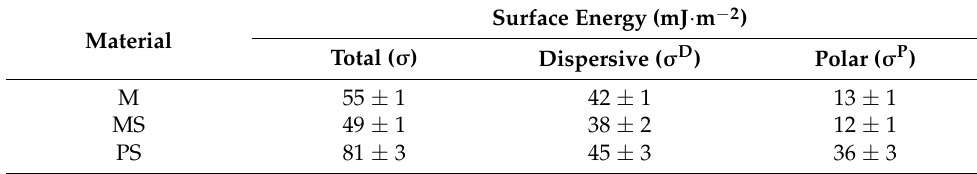
Table 3. Surface energy ( σ ) and the dispersive ( σ D ) and polar ( σ P ) components for the PET- supported (MS) and non-supported (M) membranes and the support layer (PS), determined using the Fowkes